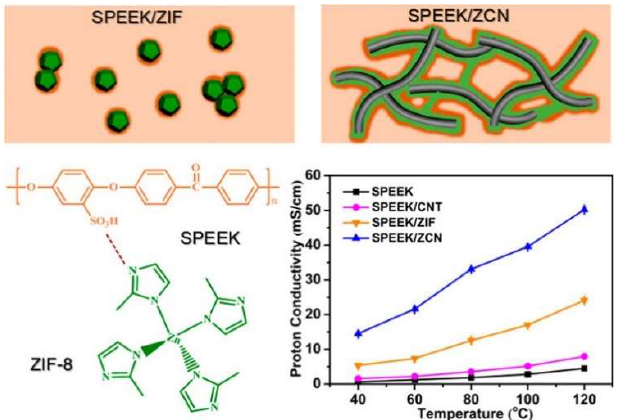
Figure 19. Interaction between SPEEK and ZIF-8, and the schematic illustration for the interface of SPEEK/ZIF and SPEEK/ZCN composite membranes. Reprinted with permission from Ref. [59]. Copyright 2017 American Chemical Society.